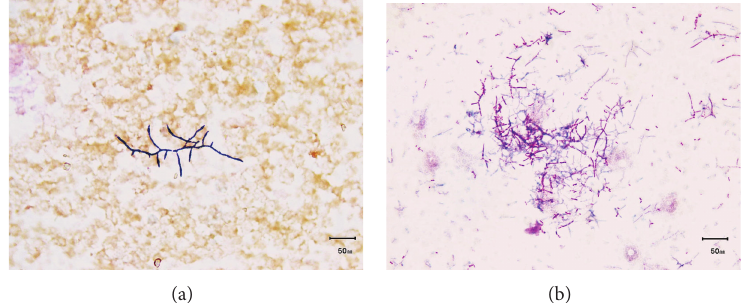
Figure 1: (a) Gram stain of blood culture showing a cluster of beaded branching filamentous Gram-positive rods. (b) Modified acid fast Kinyoun staining of blood culture showing filamentous red-stained partially acid-fast rods.